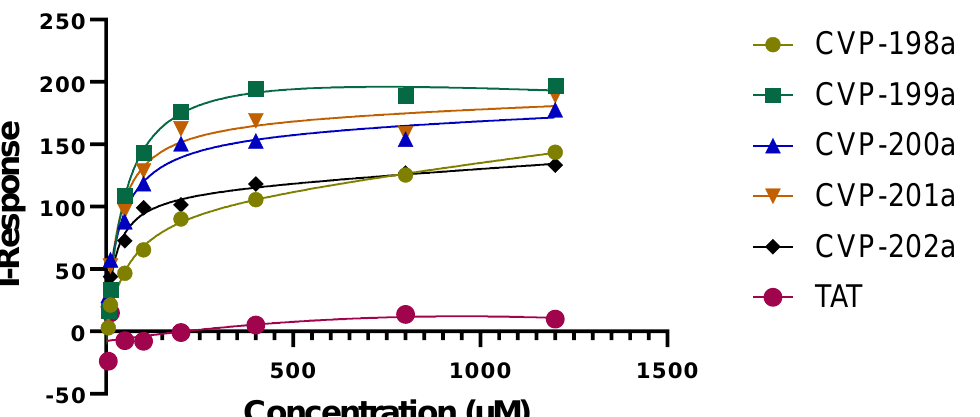
Table 1. Characterization of the developed library.